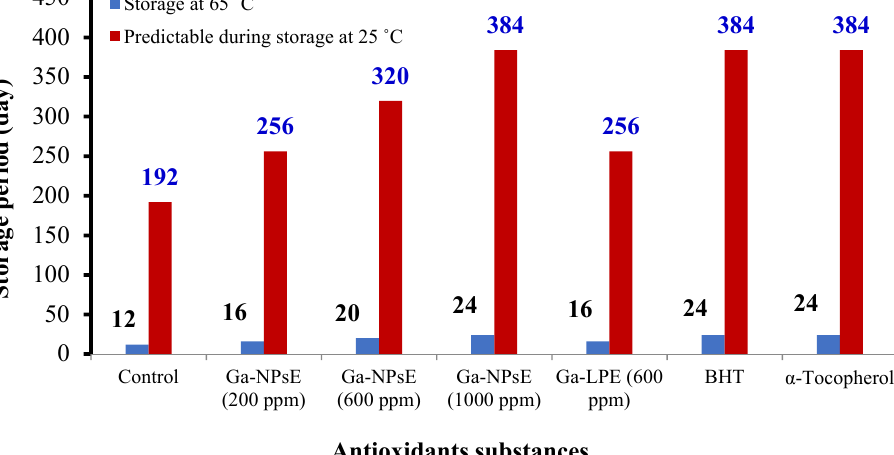
Figure 4. The shelf life of SFO during storage at 65 °C and predictable shelf life during storage at 25 °C.